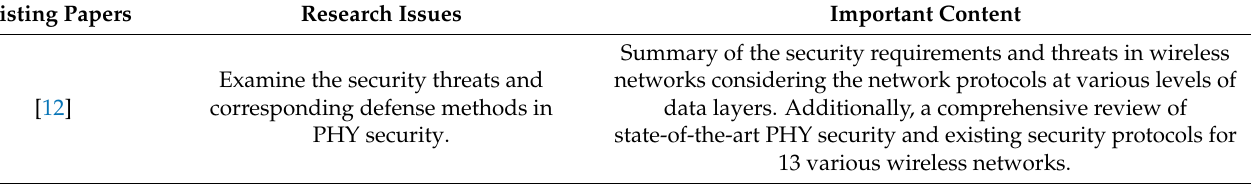
Table 1. Summary of related studies.